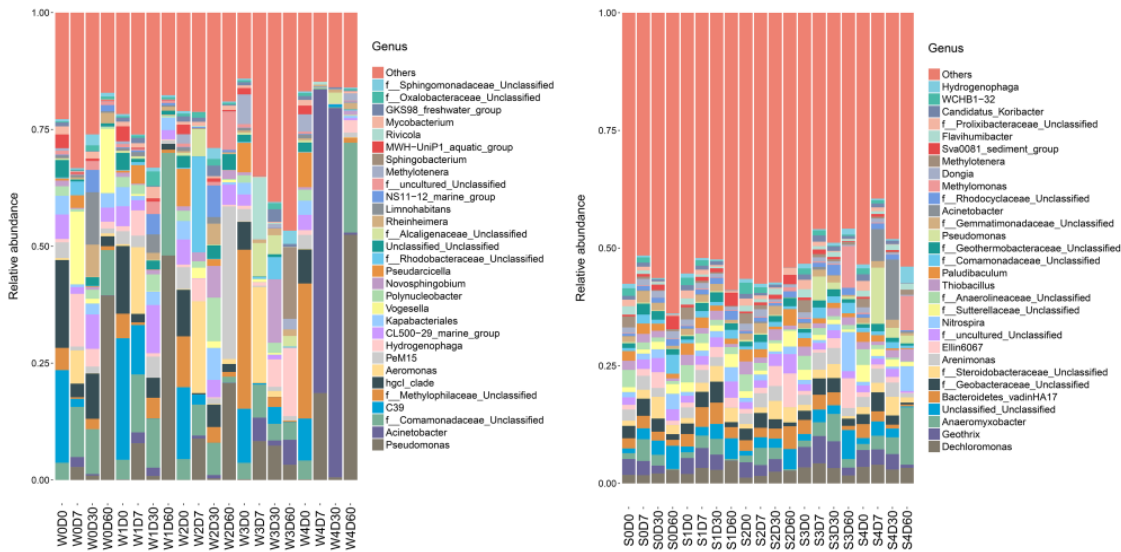
Figure 5. Effects of different concentrations of florfenicol on genus-level bacterial abundance in an aquatic microcosm model. W, water; S, sediments.